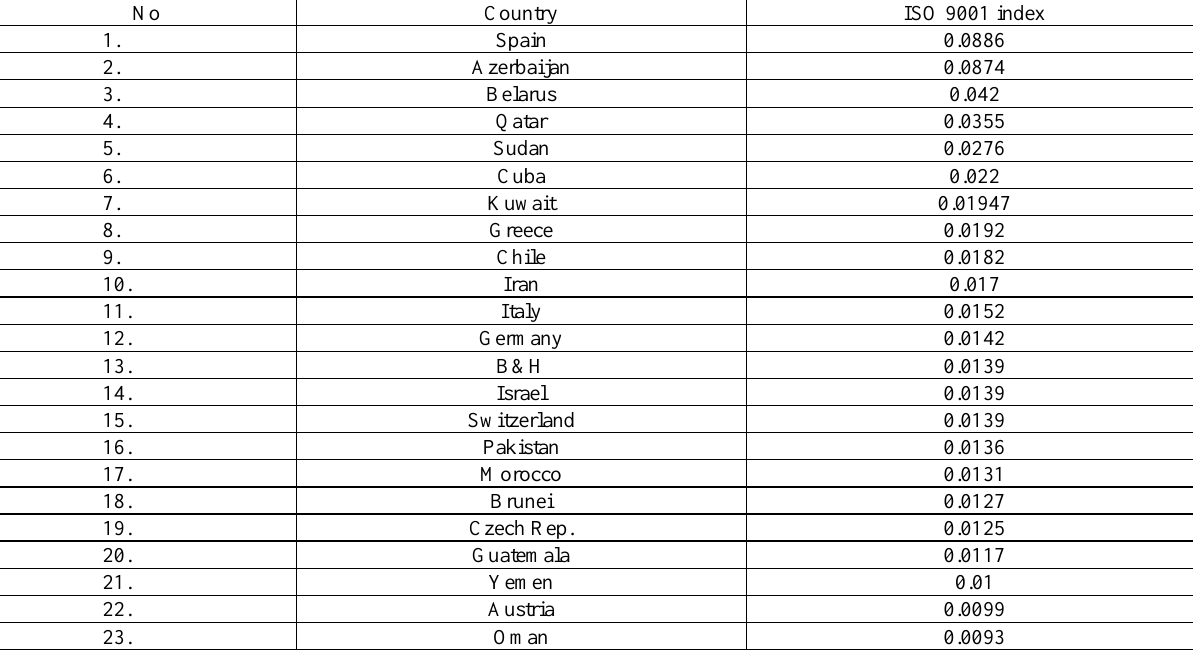
Table 3. List of countries for ISO 9001 index based on the number of ISO 9001 certificates issued divided by the number of businesses per each country (136 countries worldwide, drawn from the author of this paper) No